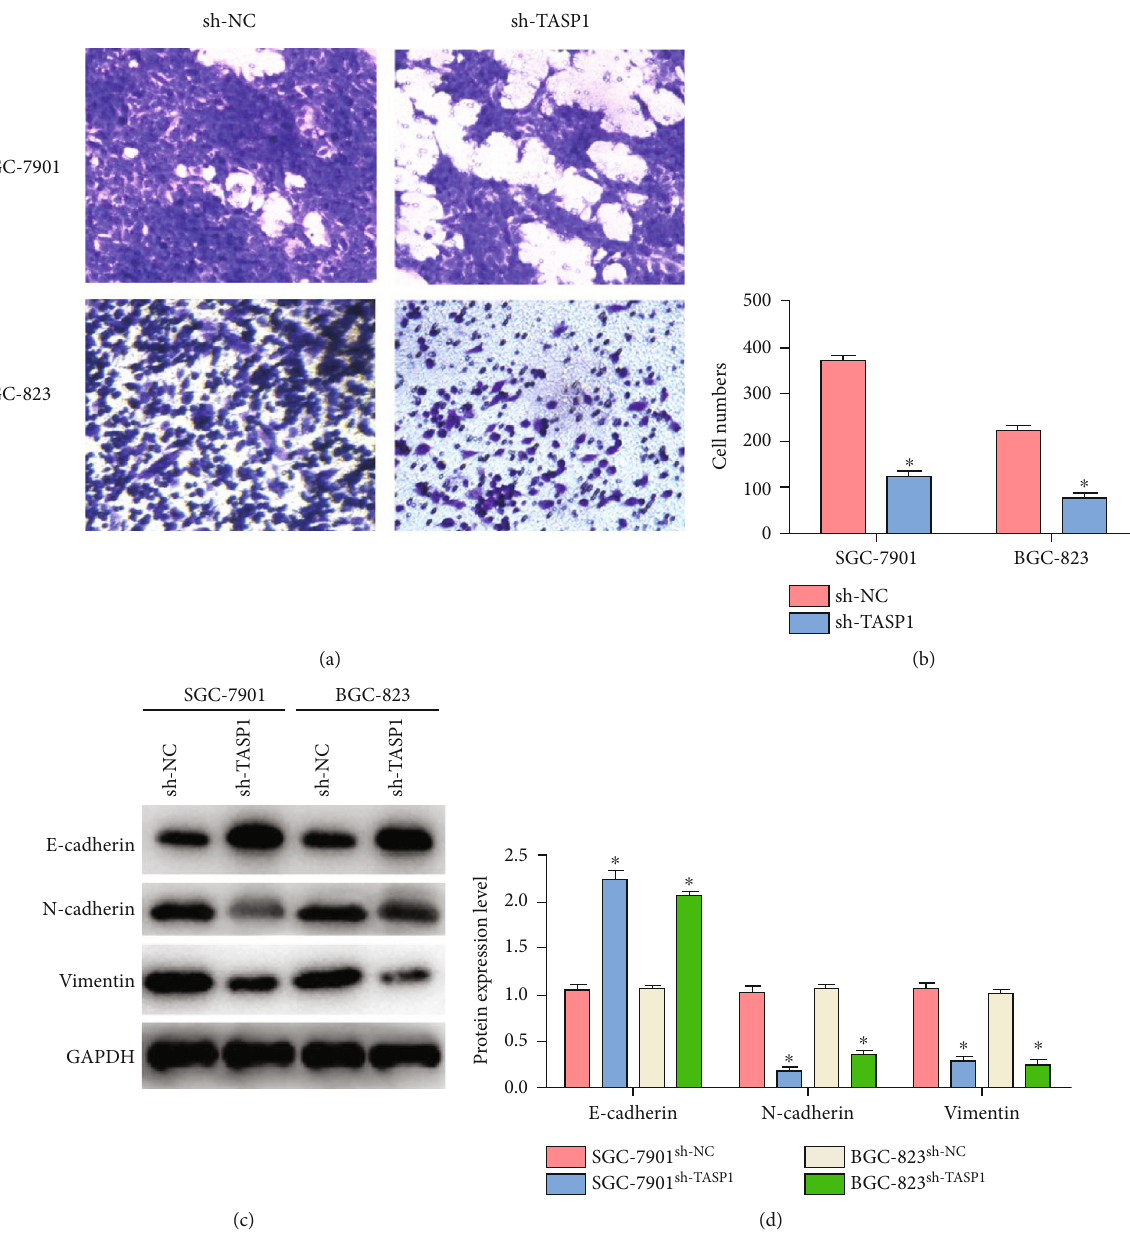
Figure 3: TASP1 promotes the migration of GC cells by regulating the levels of E-cadherin, N-cadherin, and vimentin. (a, b) Imaging analysis of the migration ability of SGC-7901 cells and BGC-823 cells transfected with sh-TASP1 and evaluating their statistical signi fi cance based on the numbers of migrated cells ð ∗ p < 0 : 05 Þ . (c, d) Expression levels of E-cadherin, N-cadherin, and vimentin in SGC-7901 cells and BGC-823 cells transfected with sh-TASP1s ð ∗ p < 0 : 05 Þ